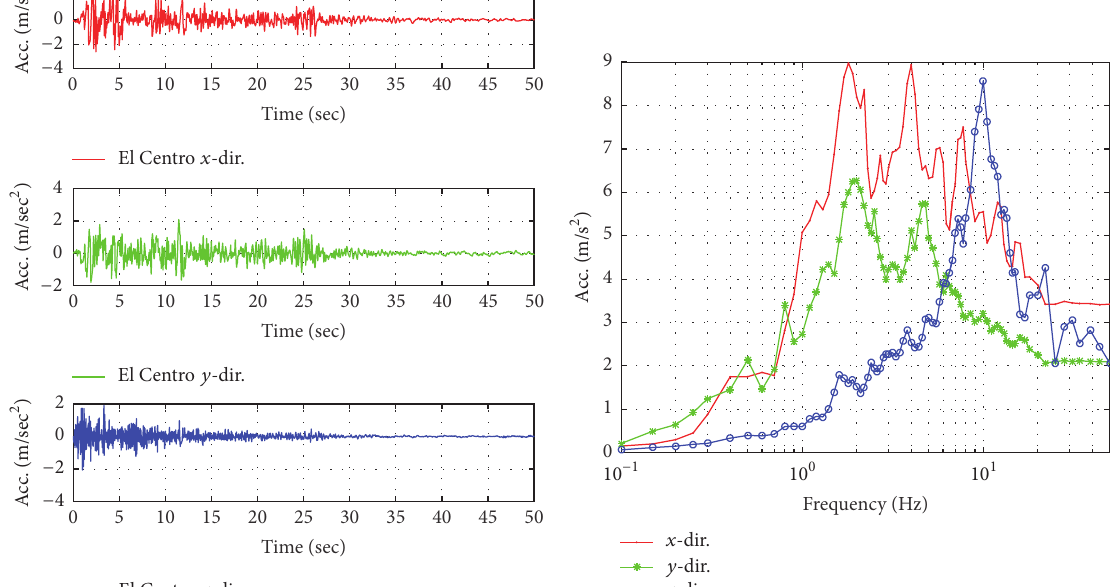
Figure 6: Sine sweep wave and its FFT.